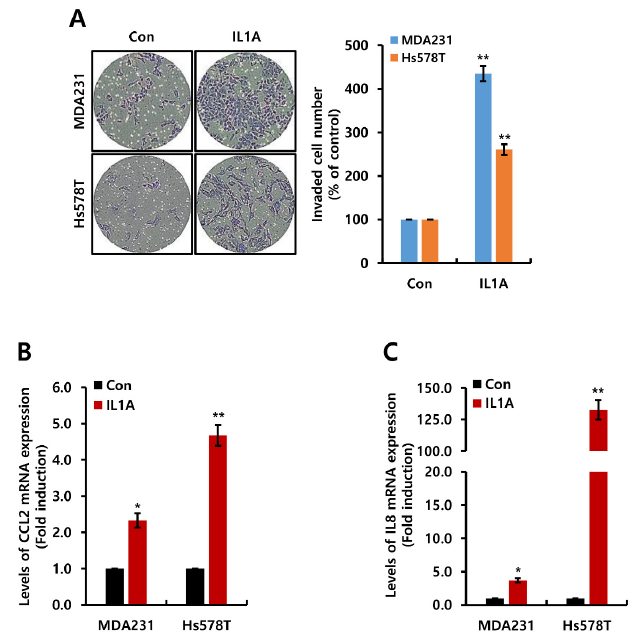
Figure 4. IL1A increased cell invasiveness in TNBC cells. ( A – C ) after cell-seeding, TNBC cells were treated with 20 ng/mL IL1A for 24 h. ( A ) cell invasiveness was measured by Boyden chamber assay. The upper compartment of the insert chamber was removed using cotton swabs and the bottom filters were fixed and stained for counting invaded cells. ( B , C ) the levels of CCL2 ( B ) and IL8 ( C ) mRNA were measured through real-time PCR. The values are presented as the mean ± standard error of three independent experiments. * p < 0.05, ** p < 0.01 vs. Con. Con;